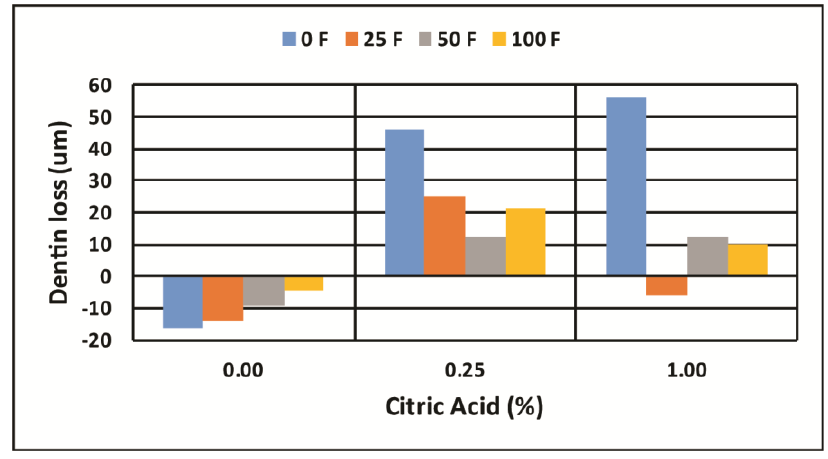
Figure 5. The amount of surface lost at 4 h of erosive challenge in the 12 experimental CA/F solutions. Negative values indicate surface gain, positive values indicate erosive loss of the dentin surface.